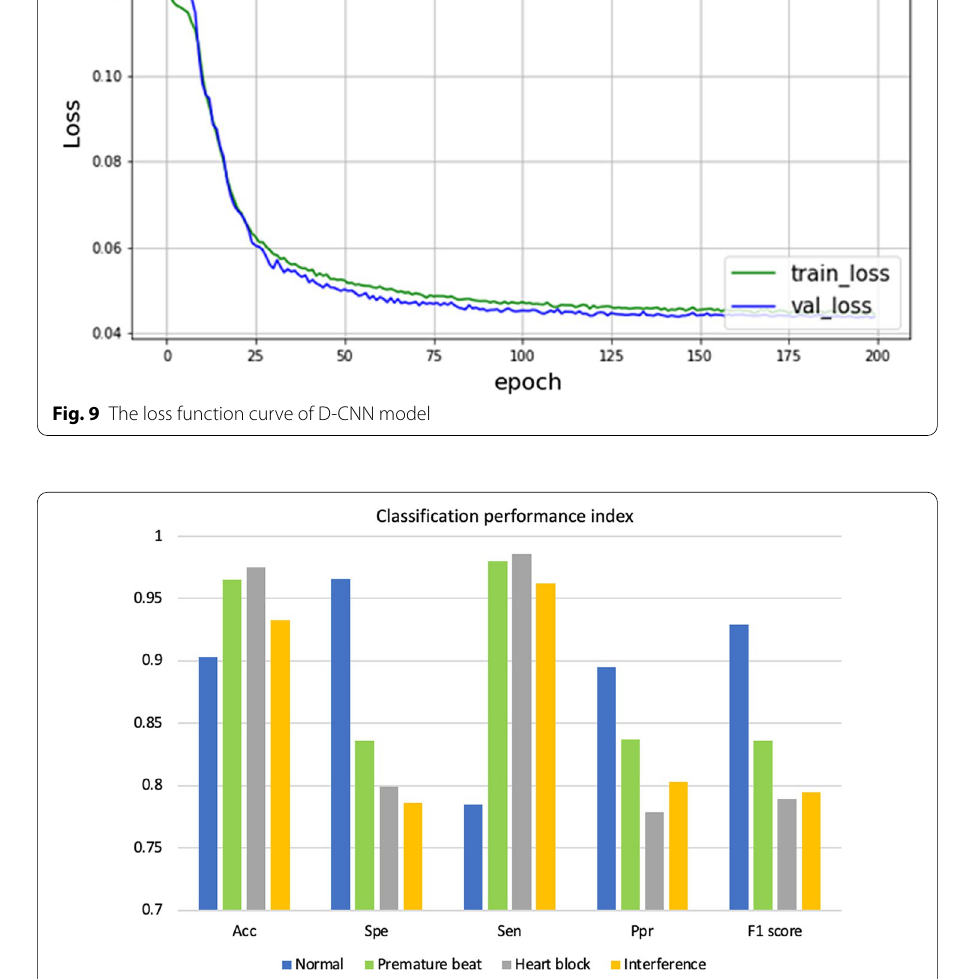
Fig. 10 Performance of the proposed